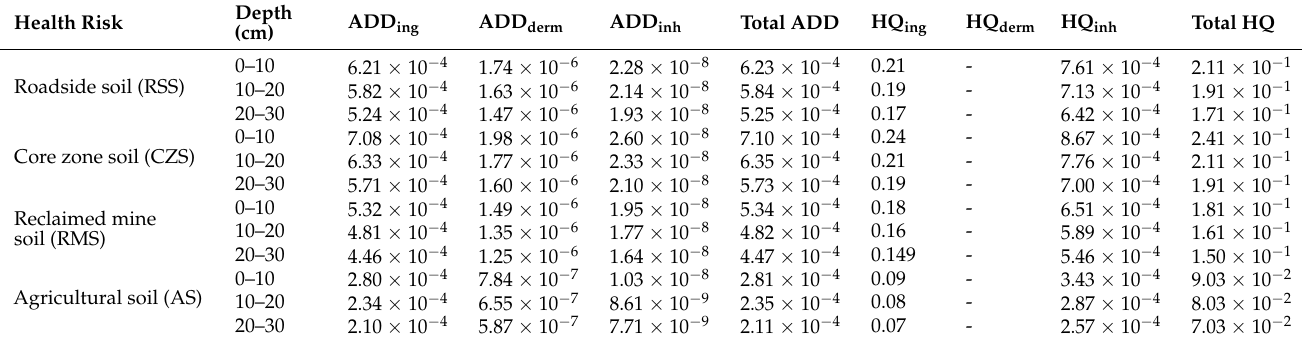
Table 1. Average daily dose (ADD) and hazard quotient (HQ) of Cr in three soil profiles (0–10, 10–20 and 20–30 cm) of different land-use areas of coal mine, Jharia coalfield.